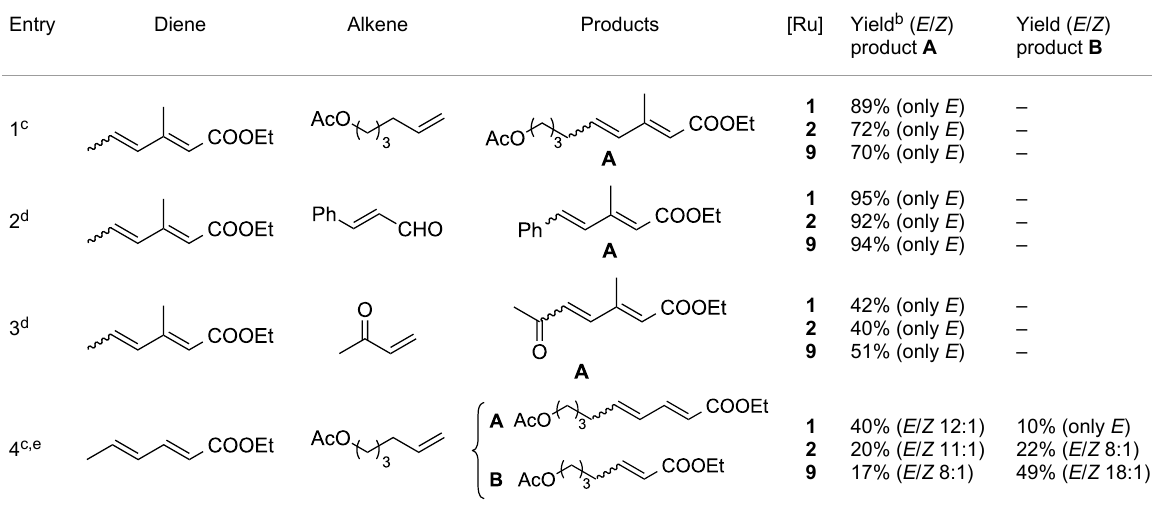
Table 4: CM reactions between dienes and alkenes in the presence of various 2 nd -generation catalysts a . Entry Diene Alkene Products [Ru]